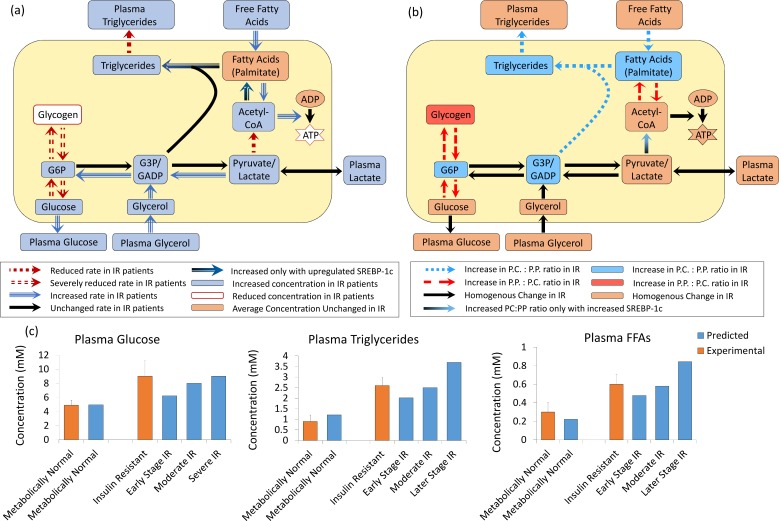
(a) The effects of simulating IR on total hepatic metabolism (averaged across the sinusoid). (b) The heterogeneity in the effects of simulating IR across the sinusoid. (c) The effects of simulating increasing severities of IR on plasma triglyceride, glucose and FFA concentrations compared with experimental data from Sindelka et al [65] and Burnt et al. [66].